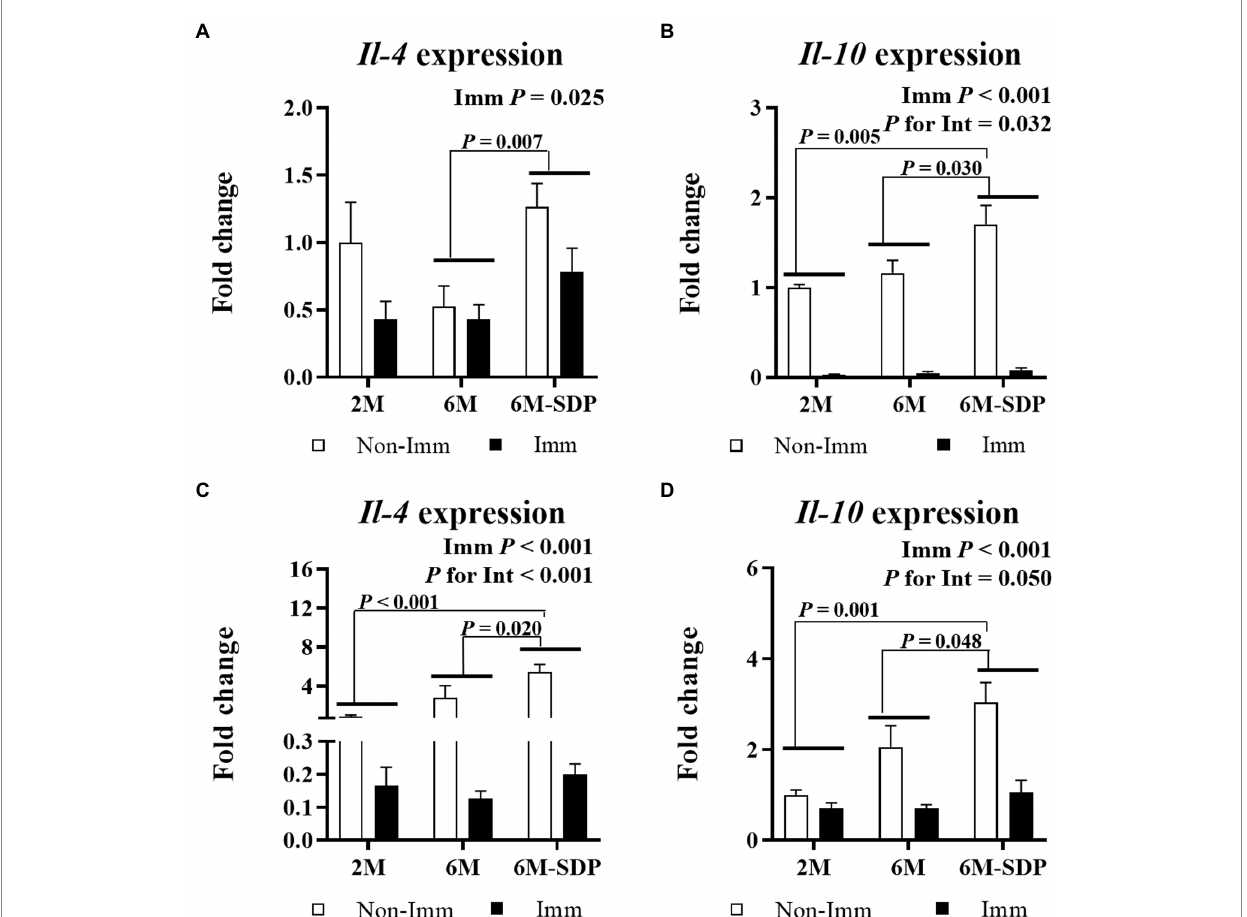
FIGURE 9 mRNA expression of Il-4 and Il-10 in the jejunal mucosa ( A and B , respectively) and in lung tissue ( C and D , respectively). Open bars represent non- immunized ( Non-Imm ) mice; solid bars represent immunized ( Imm ) mice. All target genes were normalized to Gus β expression. The fold-change expression is against immunized 2 M mice. Results are expressed as means ± SEMs ( n = 9–10 animals). Statistics: two-way ANOVA (age-feed and immunization factors; Fisher multiple comparison test). Int indicates the interaction between immunization and age-feed factors. Gus β , glucuronidase beta; Il, interleukin; SDP, spray-dried porcine